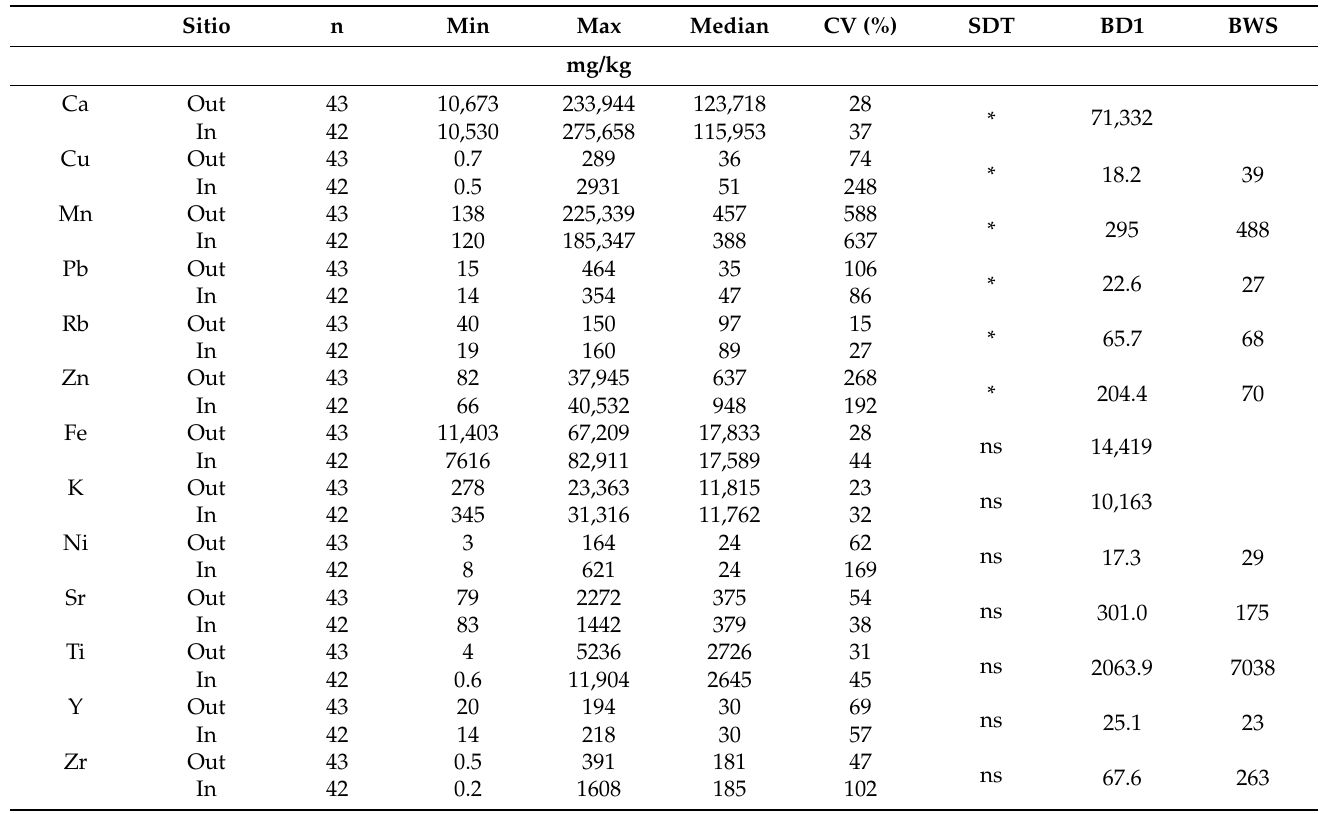
Table 1. Statistical summary of the concentrations of heavy metals outdoors and indoors in the city of G ó mez Palacio,